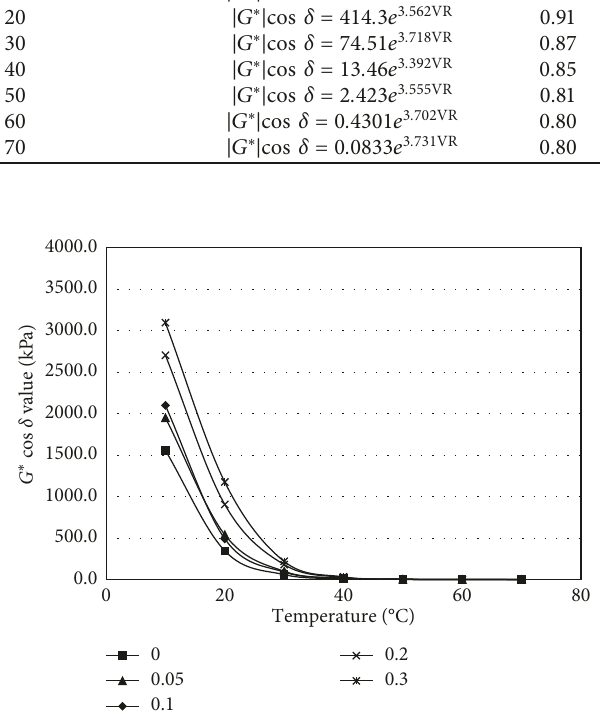
Figure 10: (1.78Hz).